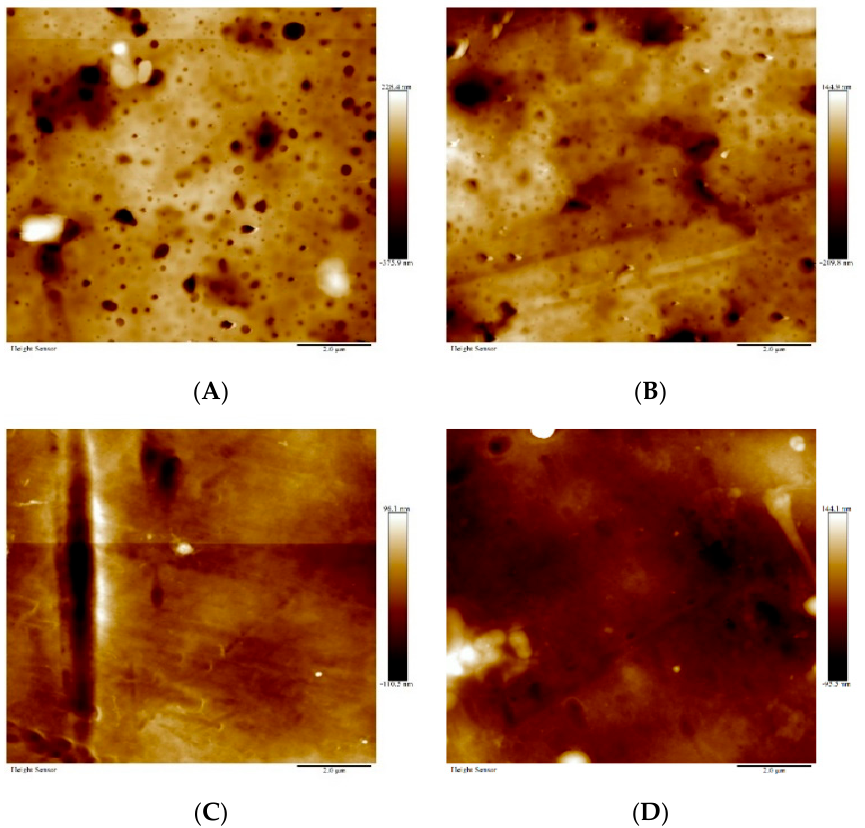
Figure 7. Atomic force microscope (AFM) images of membrane surface after treatment: ( A ) Plain/clean membrane, ( B ) the membrane after filtration of PFOA, ( C ) the membrane after filtration of PFOA and irradiation with UV, and ( D ) the membrane after filtration of PFOA and oxygenation.